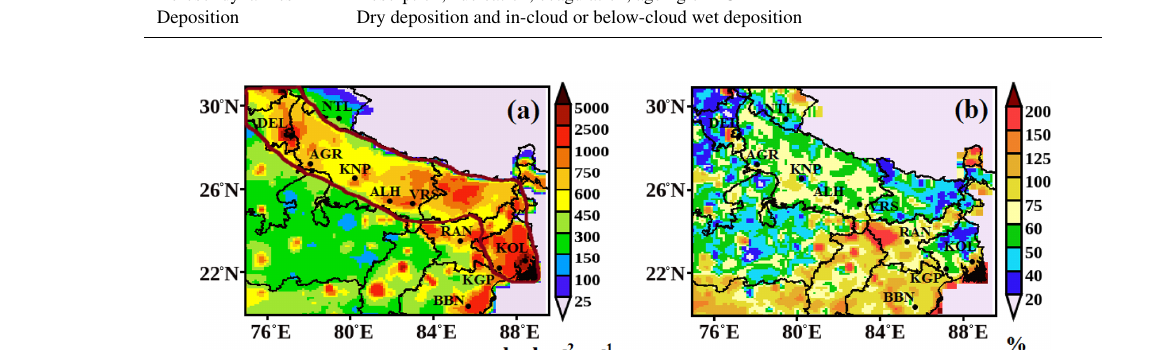
Figure 1. Spatial distribution of (a) the mean and (b) percentage deviation ( δ ) of the BC emission flux from five BC emission inventories implemented in CHIMERE over the study domain; the brown line in (a) indicates the IGP